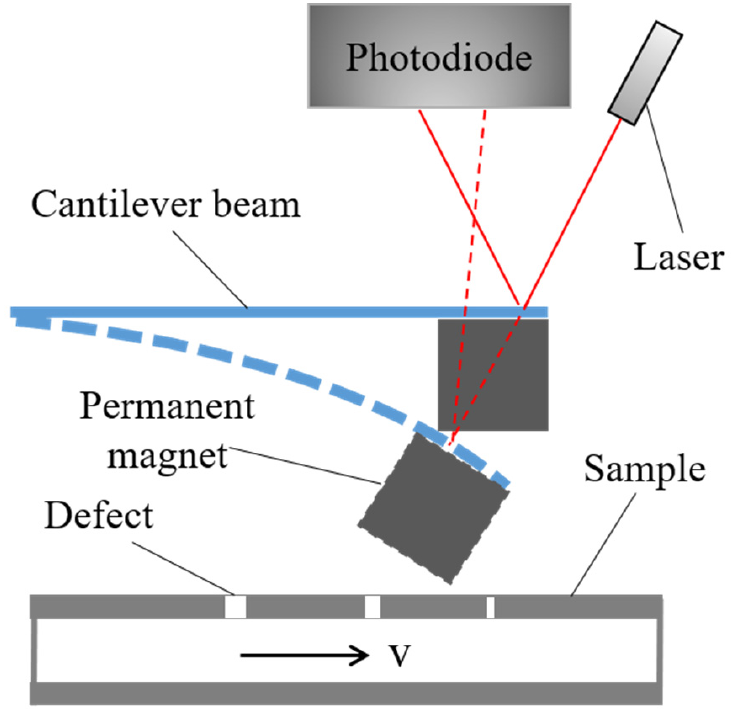
Figure 2. Magnetostatic force sensor used to detect small forces acting on the permanent magnet adhered to via elastic deformation of the cantilever beam. The solid and dotted lines represent the deformation of cantilever beam and the laser path with and without defects, respectively.